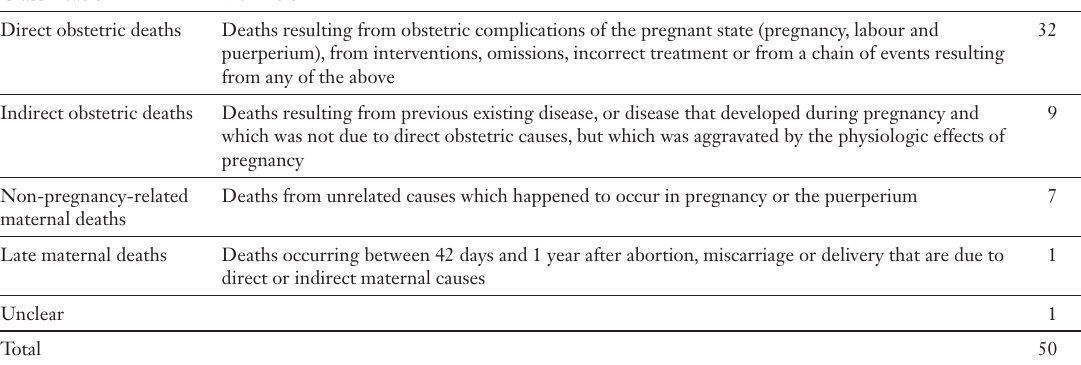
Classification of maternal deaths (ICD-10) [7, 8].